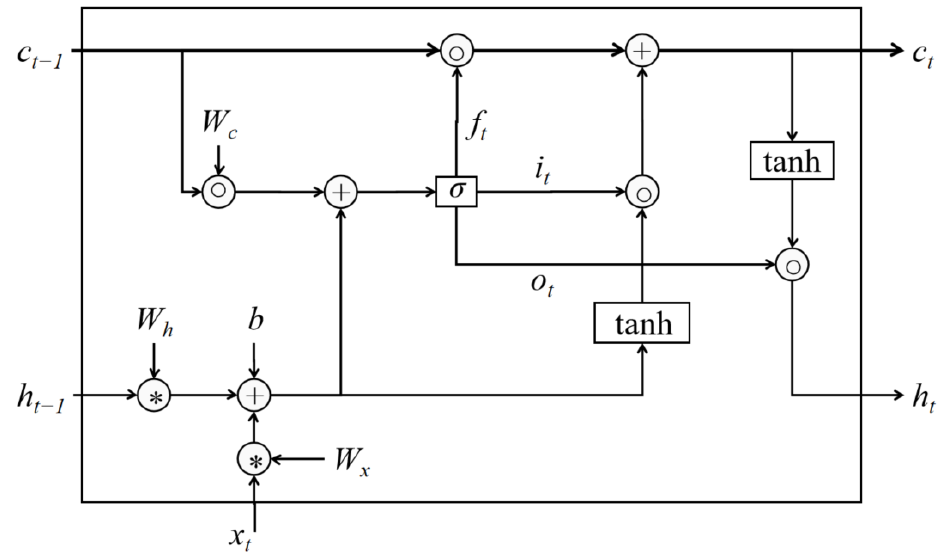
Figure 1. Schematic diagram of ConvLSTM structure. σ and tanh are the activation function, * represents the convolution operator, ° represents the Hadamard product, and + represents plus.